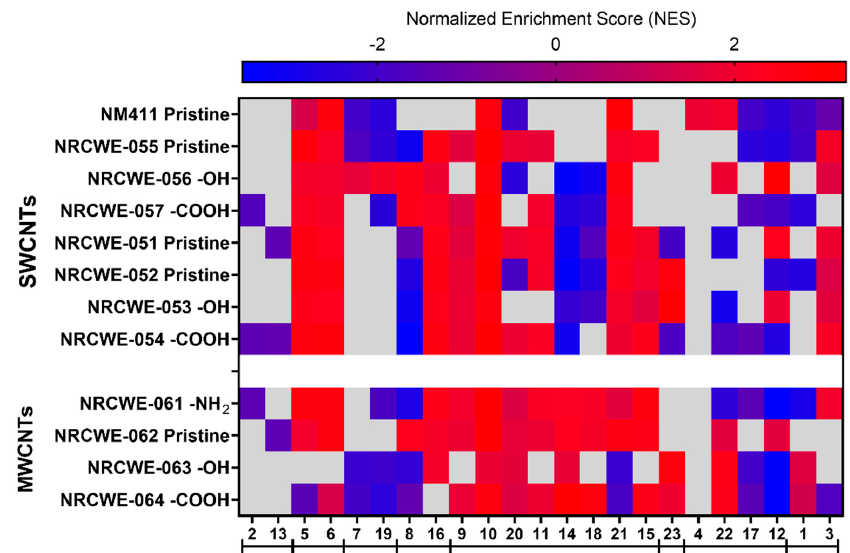
Figure 9. Modules over-represented or under-represented after 1 day of exposure to CNTs at the 18 µ g/mouse dose. Red: positive NES values represent gene set enrichment at the top of the ranked list. Blue: negative values represent gene set enrichment at the bottom of the ranked list. Enriched sets were considered significant if their NES had an adjusted p -value ≤ 0.05 (gray represents modules that were not significant). The bars group the modules with similar biological functions based on the IPA analysis.